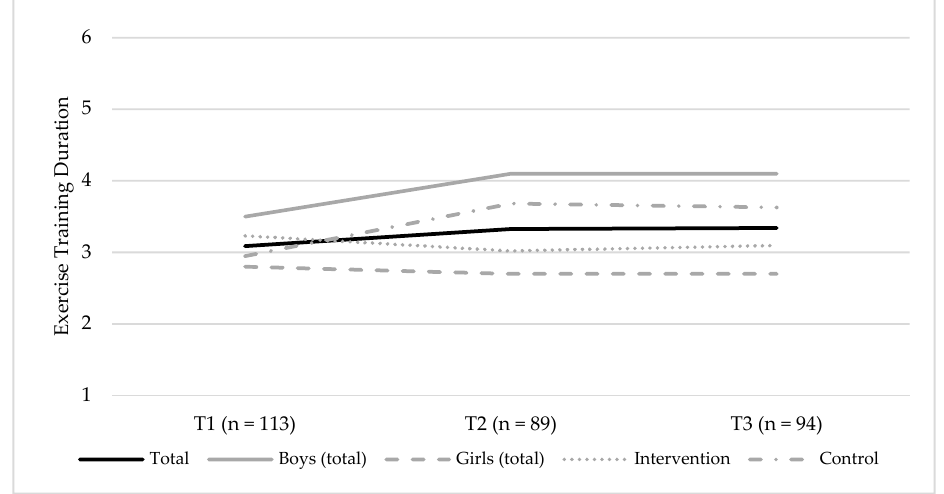
Figure 4. Changes in the self-reported exercise training (ET) duration, between T1 (baseline, 2014) and T3 (endpoint, 2016), for the total sample, boys (total sample), and girls (total sample), and the intervention and control groups, respectively. The figure shows the mean group levels of ET duration, and the possible responses were coded as follows: 1 = none; 2 = about 30 min; 3 = about 1 h; 4 = about 2–3 h; 5 = about 4–6 h; and 6 = about 7 h or more.